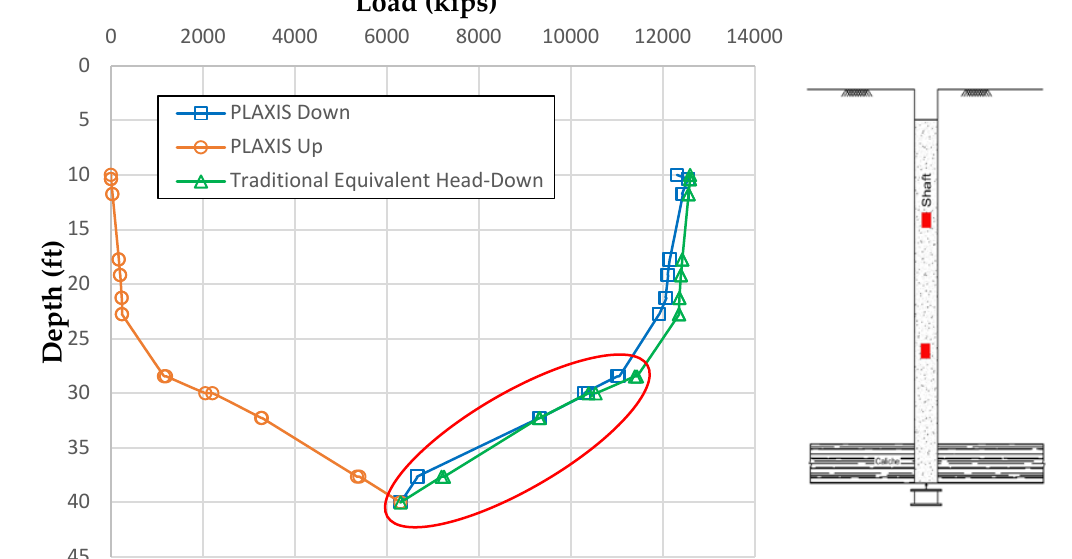
Figure 11. Load transfer distribution of the upward and downward loading, along with the top-down load application in the soil containing competent caliche layers, based on the finite element simulation of Case Study II.